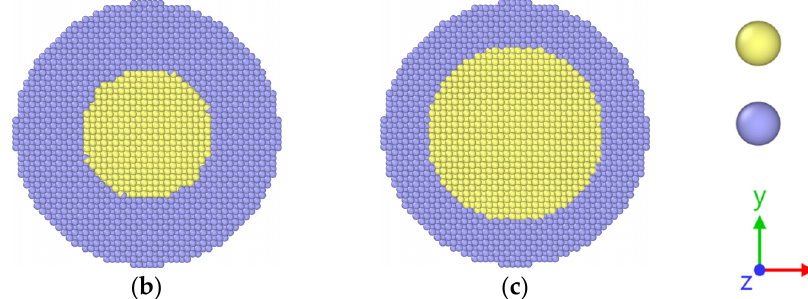
Figure 1. Initial modeling of Ti–Al core–shell NPs with a core volume fraction of ( a ) 3%, ( b ) 12%, and ( c ) 30%. The Ti core and the Al shell are colored yellow and blue, respectively.